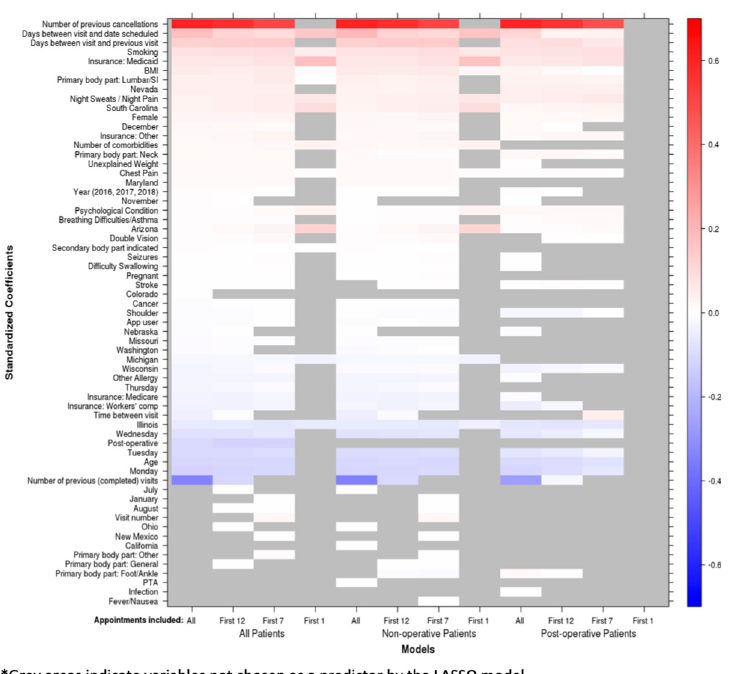
Fig 3. Variables predictive of a patient not showing up (red) and showing up (blue) for an appointment.